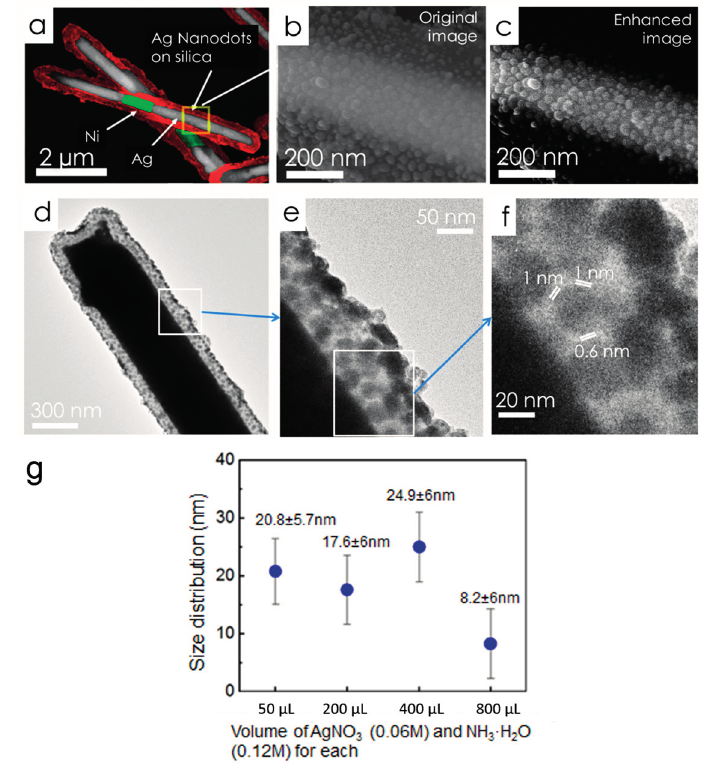
Figure 7. Color enhanced SEM images of tri-layer nanocapsules at ( a ) low magnification and ( b ) high magnification; ( c ) The contrast enhanced image of ( b ); ( d , e ) TEM images of